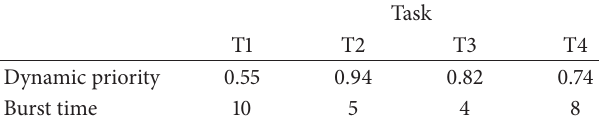
Table 6: Outcomes of Task Set 2.